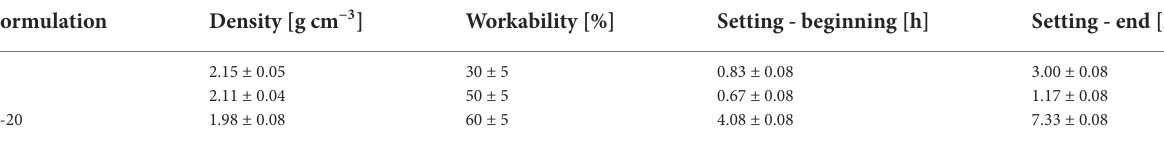
Figure 6 . It should be noted that the inhomogeneities